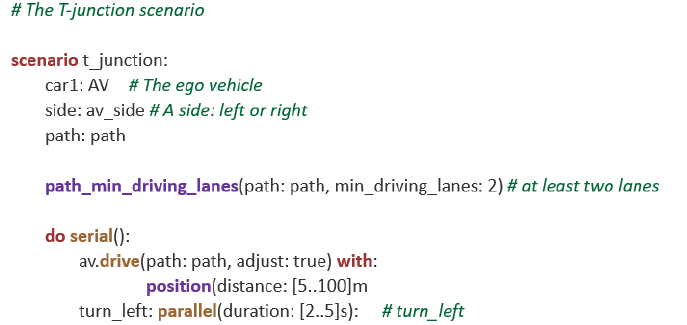
Figure 13. Example scenario in